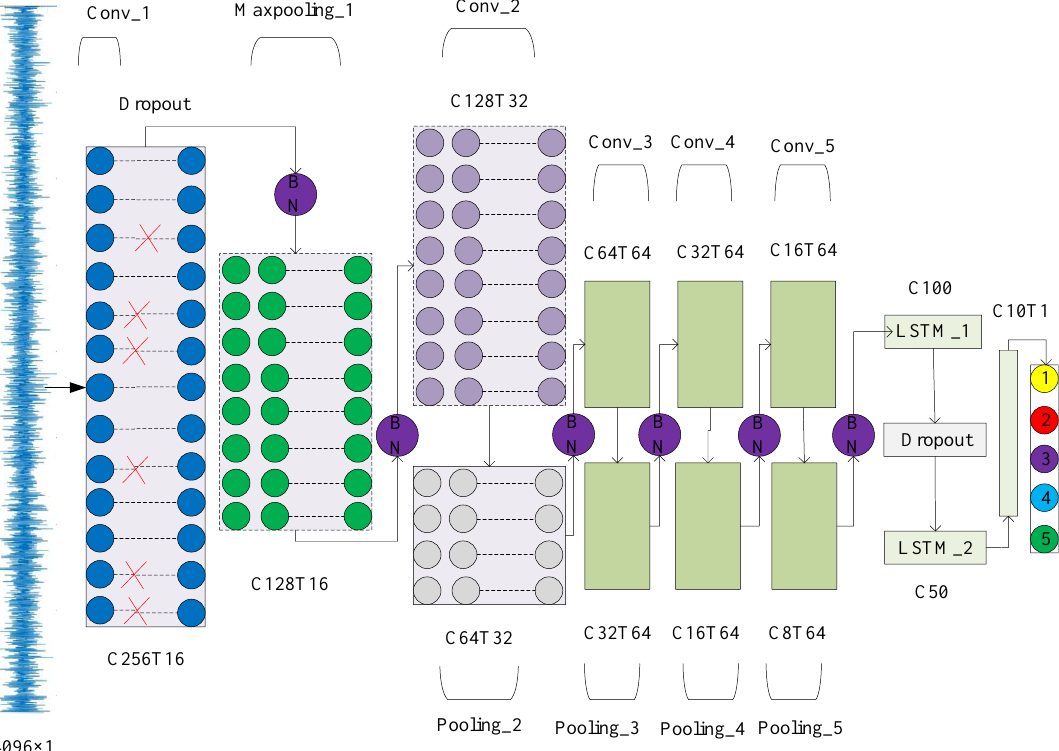
Figure 6. WDCNN model and its output parameters.